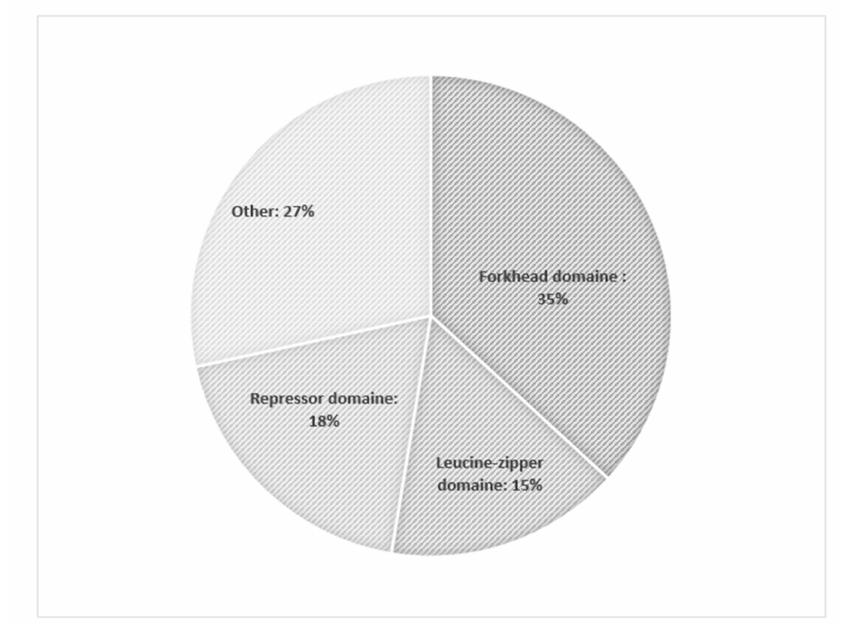
Figure 1. The occurrence of most the common mutations of forkhead box P3 (FOXP3) in patients with IPEX (immune dysregulation, polyendocrinopathy, enteropathy, X-linked) syndrome according Park et al.